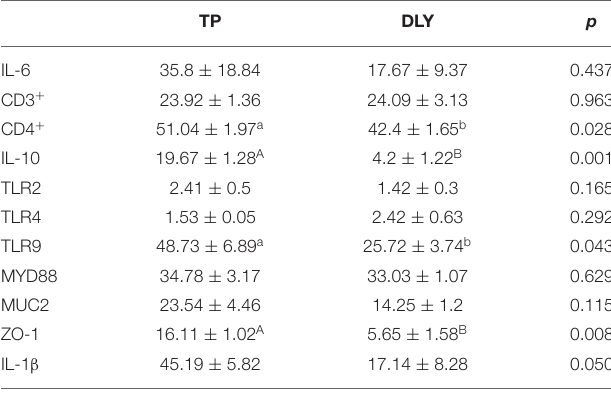
FIGURE 1 | Venn diagram of jejunum chyme of growing TP pigs and DLY pigs.